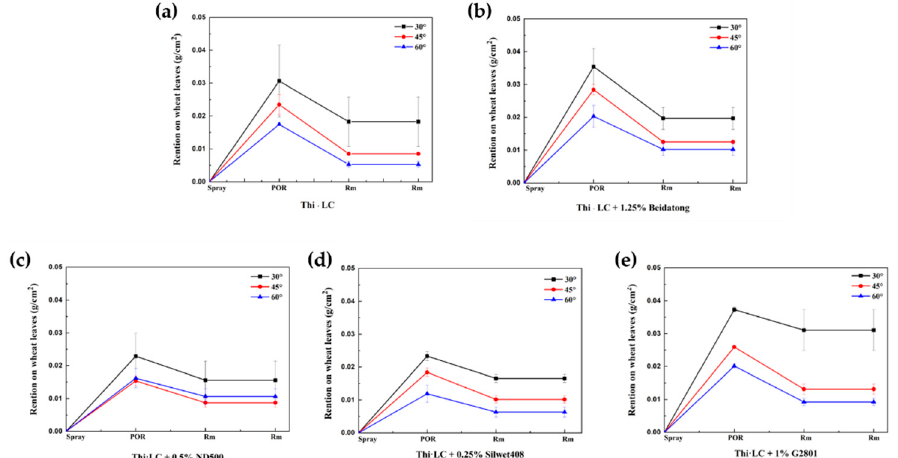
Figure 7. POR and R m values of Thi · LC droplets ( a ) and Thi · LC droplets were added with four adjuvants ( b – e ).